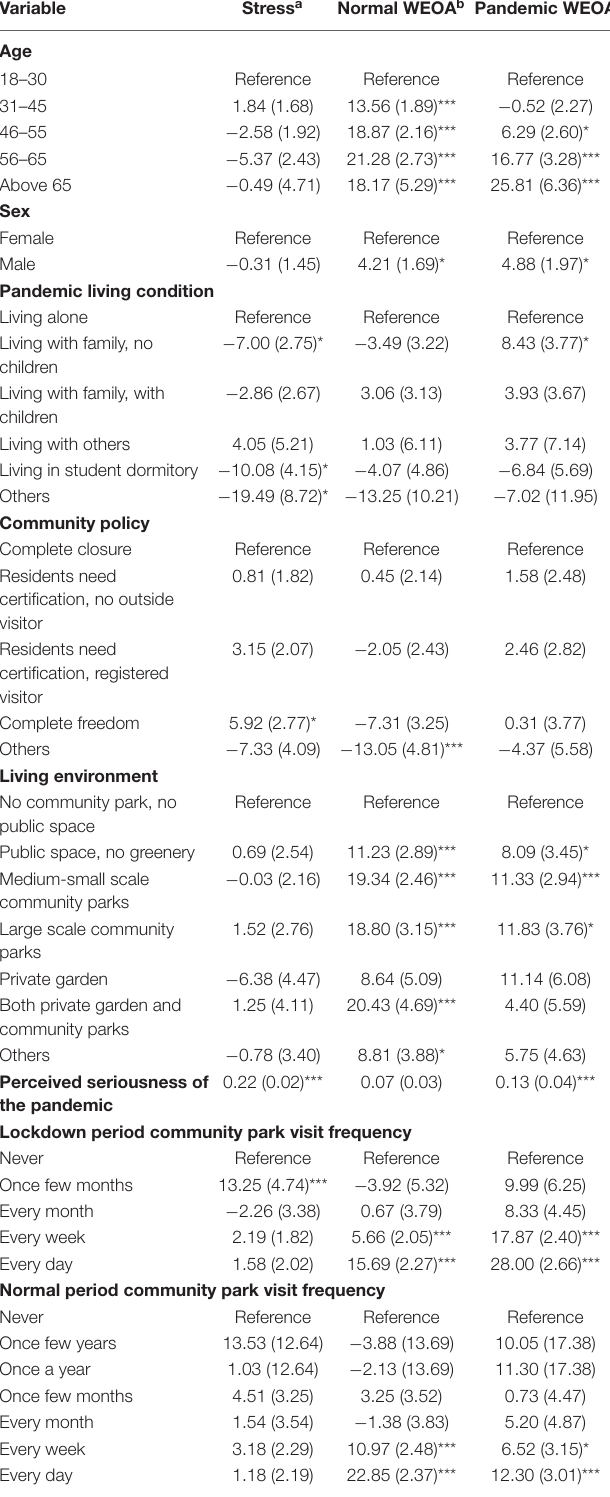
TABLE 3 | Ordinary least squares (OLS) regression models linking community park use and outdoor activity to stress level ( N = 1,342). Variable